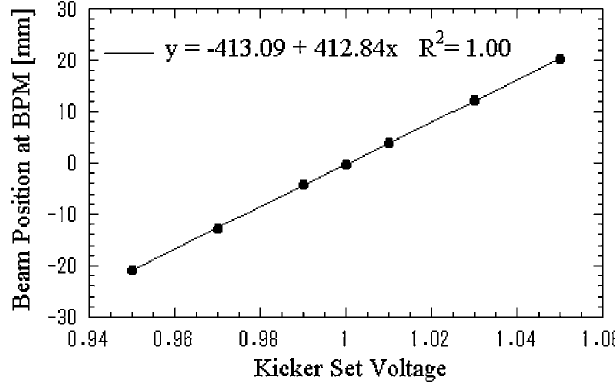
FIG. 7. The beam position shift corresponding to the kicker set voltage which is normalized by the normal